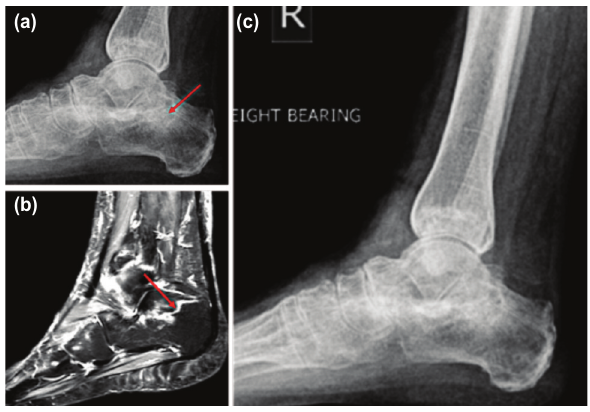
(a) Plain radiograph of the calcaneus with a suspicious Fig. 2: fracture. (b) T2 weighted MRI images of the calcaneus showing insufficiency fracture. (c) Plain radiograph of the calcaneus showing the healed fracture.